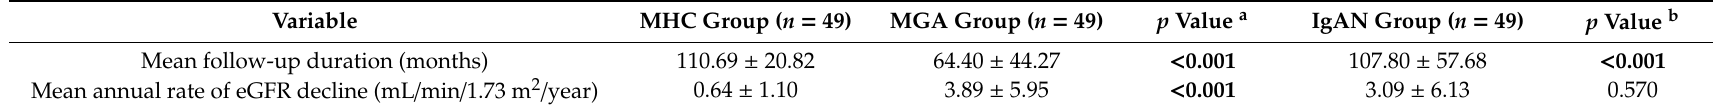
Table 2. Changes in eGFR in the MGA, MHC, and IgAN groups in the retrospective study